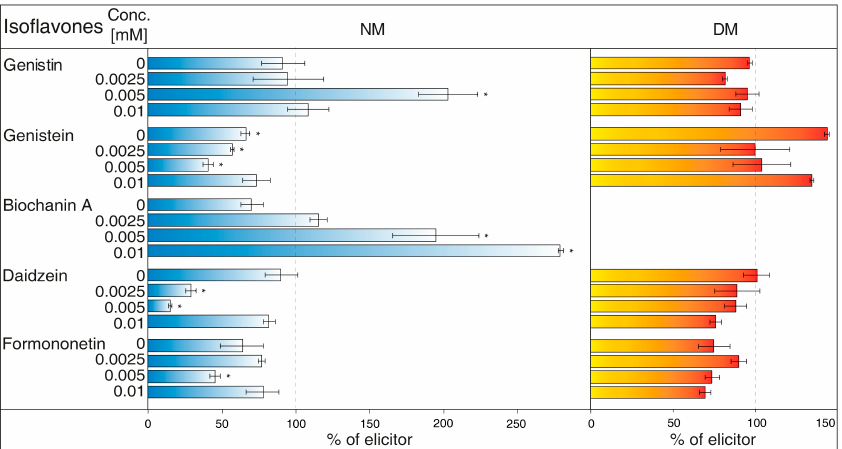
Figure 4. Effects of brefeldin A on isoflavone content in nutrient medium (NM) and dry matter (DM) of Genista tinctoria cell culture. Zero concentration of inhibitor represents water control. All bar values were recalculated to a relative 100% isoflavone content in samples with NH 4 VO 3 (1 μ M) after 24 h. Data are mean of three repeats ± SE; (*) represent significant difference ( p < 0.05) between elicited and inhibited or water control samples within Tukey’s test.